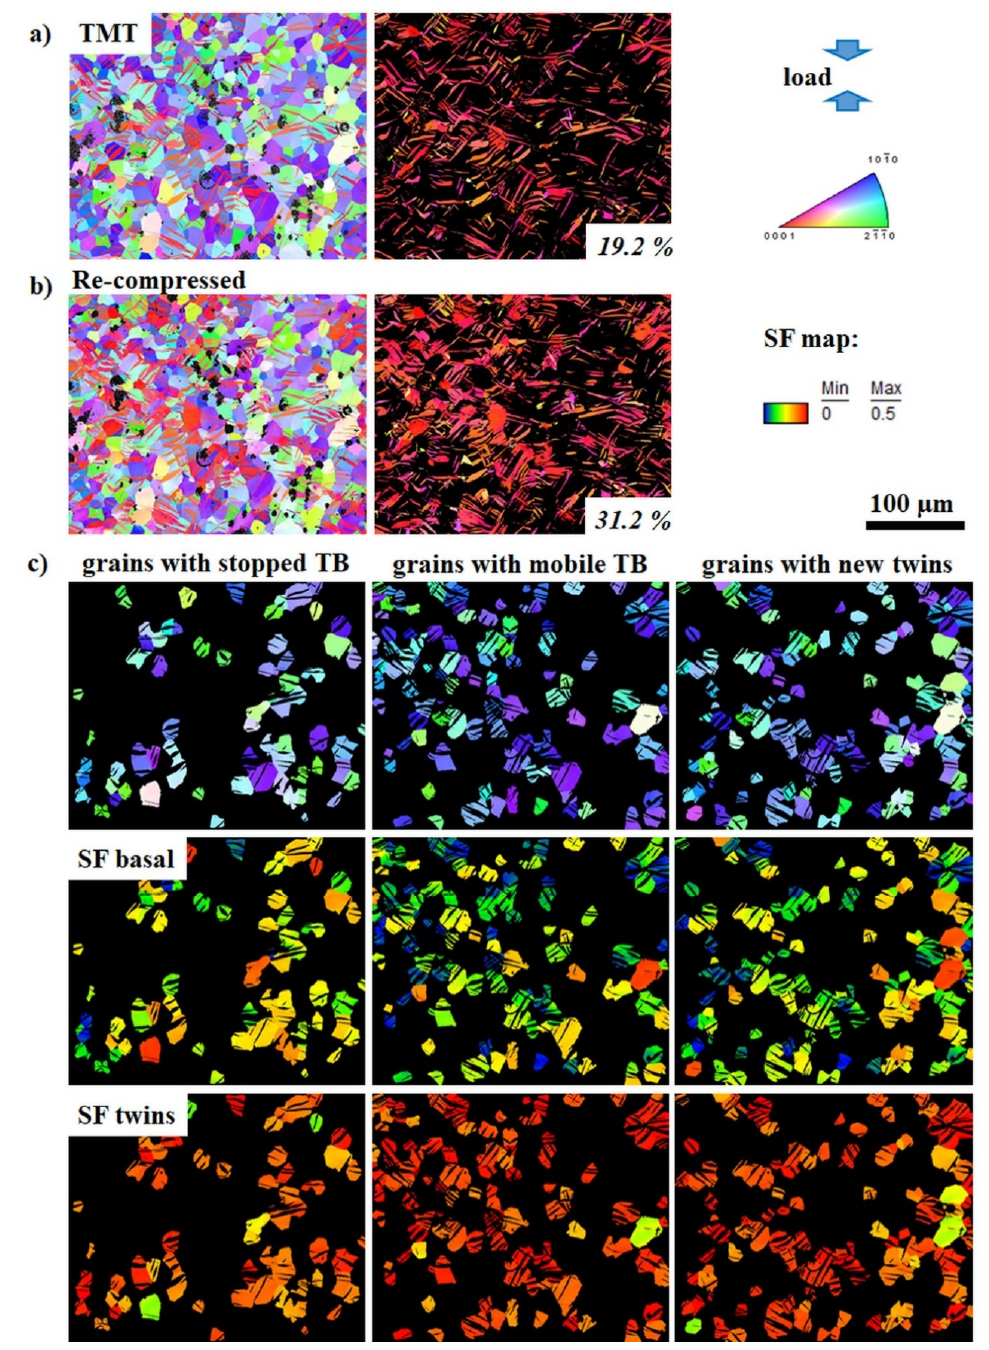
Figure 5. Orientation maps (entire microstructure and twins only) of the ZX10 alloy in the TMT state ( a ) and subsequent loading in compression up to 3% of strain ( b ). Grain grouping for TMT samples with respect to TB mobility ( c ) includes: first line–orientation maps, second and third line – Schmid Factor (SF) analysis for basal slip and extension twinning, respectively. Color code for orientation maps represents orientation with respect to ED.